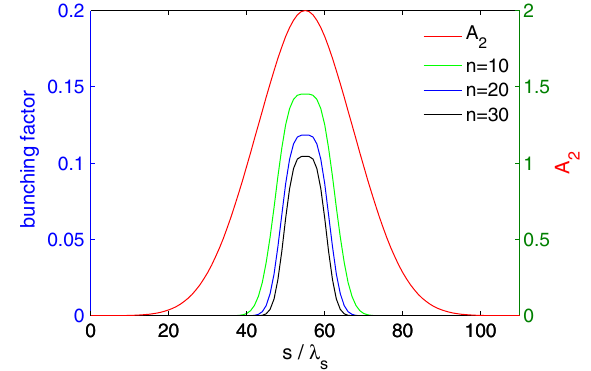
FIG. 9. Local bunching factor distributions along the electron beam for different harmonics of the seed ( n ¼ 10 , 20, and